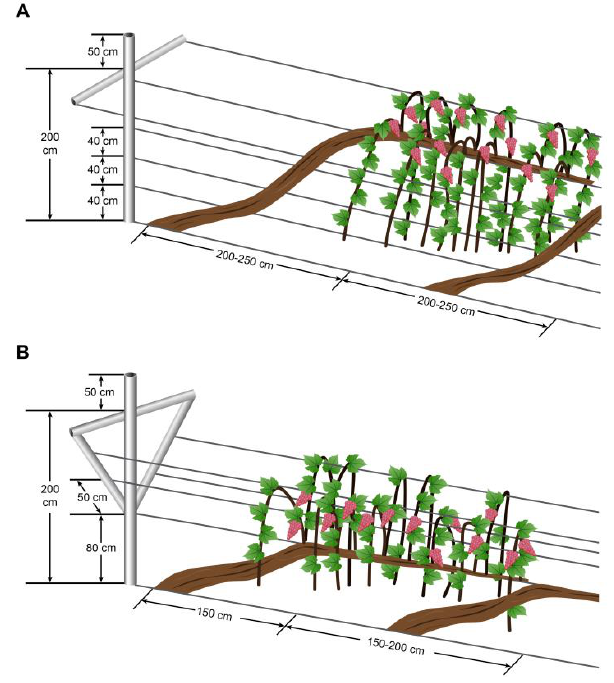
Figure 1. Sketch of the two trellis systems (( A ): the T trellis system; ( B ): the V trellis system)).